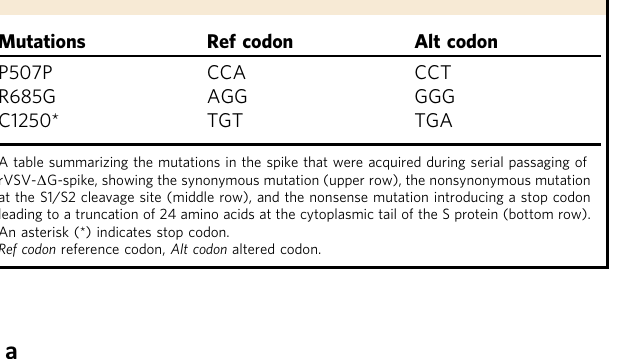
(Table 1): (1) a synonymous mutation at position 507, (2) a nonsynonymous mutation R685G — this mutation is located at the multibasic motif of the S1/S2 cleavage site of the S protein — RRAR, thus creating a RRAG site, and (3) a nonsense mutation introducing a stop codon at position 1250 of the S protein (C1250 * ), leading to truncation of 24 amino acids at the cyto- plasmic tail. Upon further passaging, the mutation at the S1/ S2 site, as well as the stop mutation resulting in Δ 24 amino acids, became dominant. Their occurrence and development, coinciding with a reduction in the VSV-G, a change in the appearance of CPE and increased viral titers suggest that these mutations may be crucial for the adaptation of rVSV- Δ G-spike to replicate in Vero E6 cells.